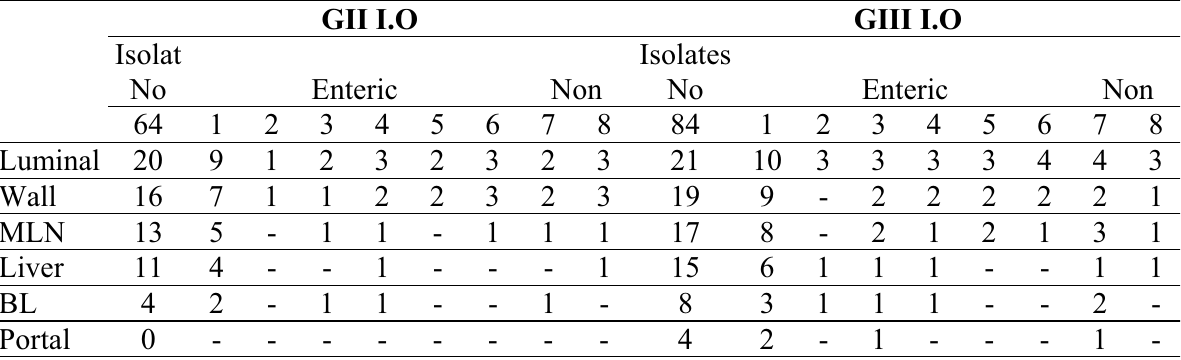
TABLE 3 - Frequency and types of isolated